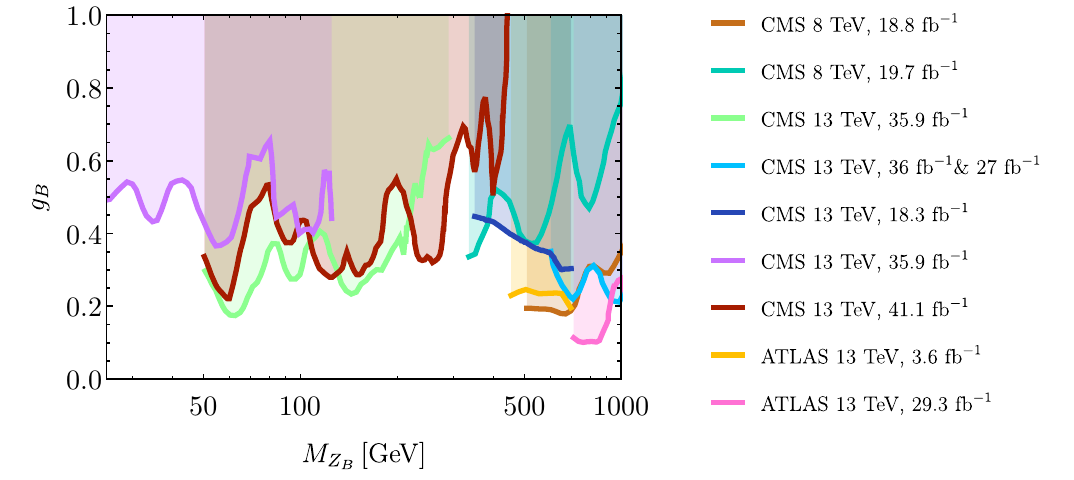
B . Here, we use the CMS